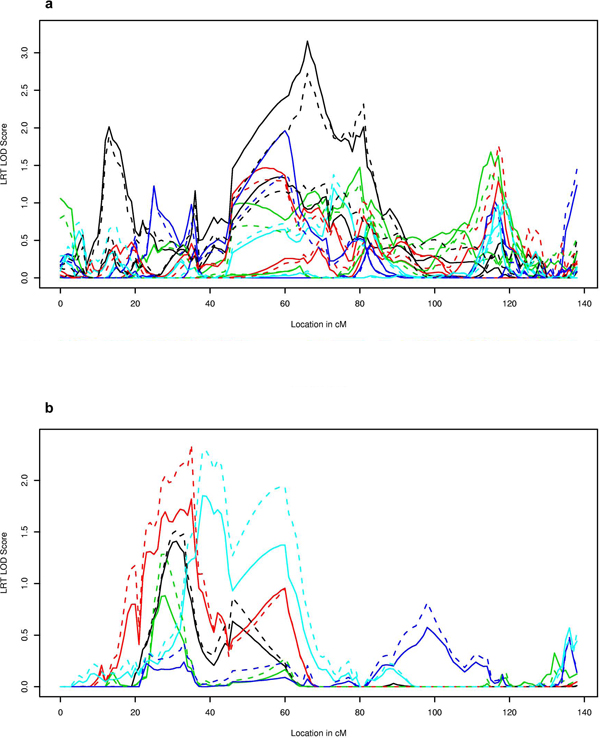
LDL Visit 1: linkage statistics (a) and TG average: linkage statistics (b). LOD score on chromosome 11: linkage score statistic (solid lines) and LRT (dashed lines). Simulation 1, black; 2, red; 3, green; 4, dark blue; 5, light blue.